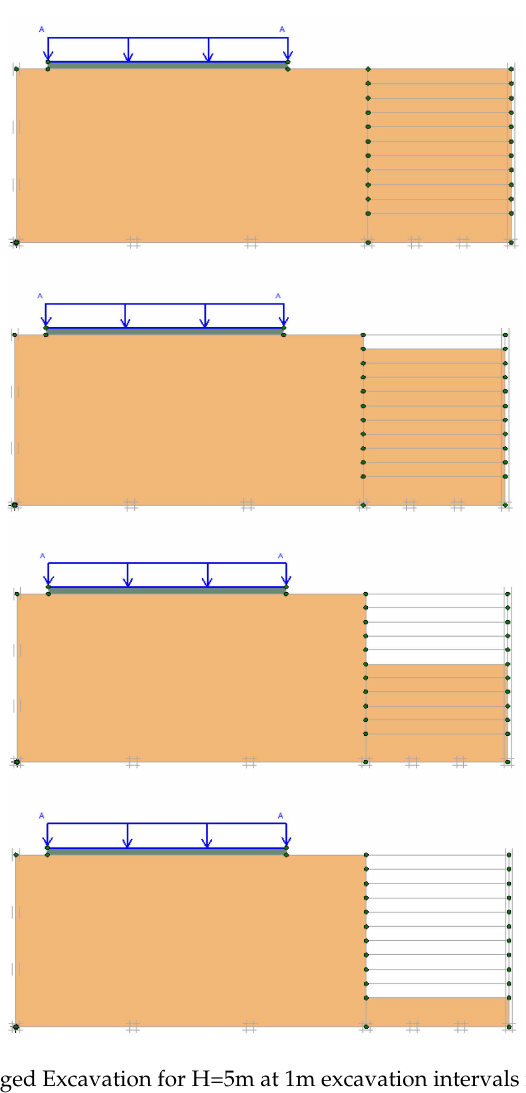
Fig. 4. Staged Excavation for H=5m at 1m excavation intervals in PLAXIS